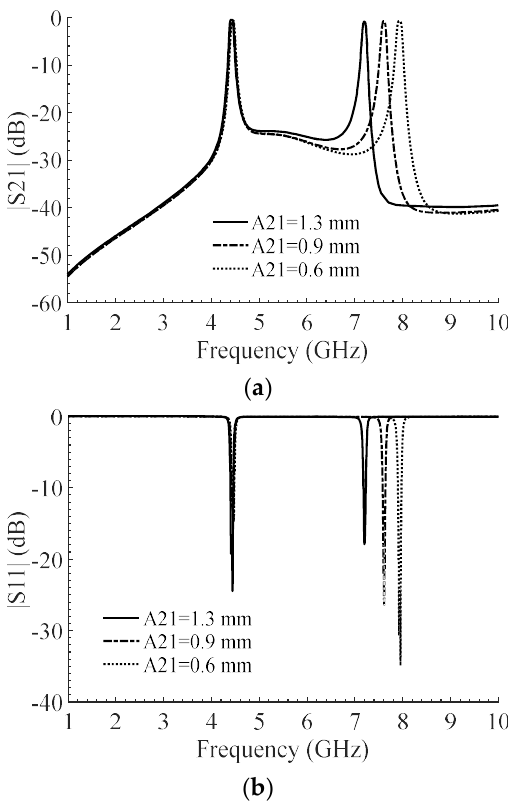
Figure 9. Adjustability of the upper band of the proposed BPF by varying A 21 : ( a ) |S 21 |, ( b ) |S 11 |.